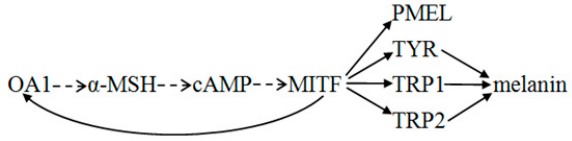
Figure 5. Potential pathway of OA1 in regulating melanogenesis in mouse melanocytes. Dotted Potential pathway of OA1 in regulating melanogenesis in mouse melanocytes. arrows—to be verified; solid arrows—verified. Dotted arrows—to be verified; solid